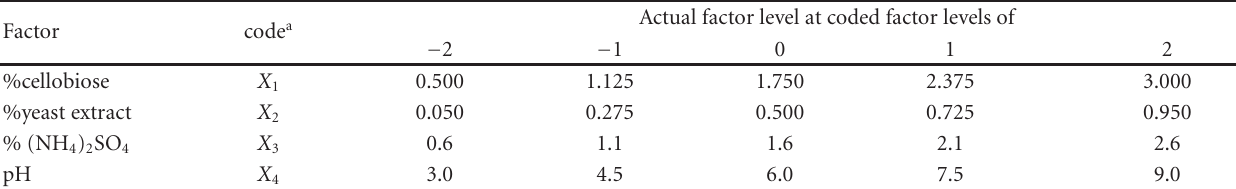
Table 1: Process variables used in the central composite design ( K = 3) with actual factor levels corresponding to coded factor levels.